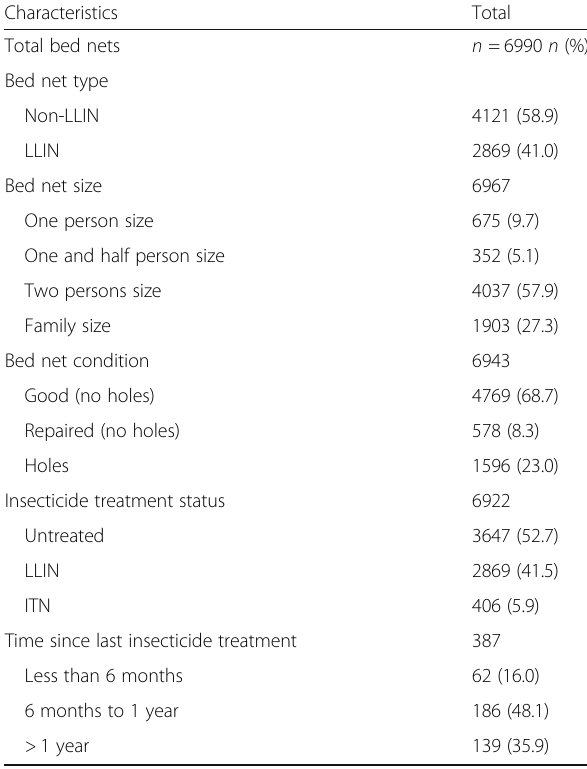
Table 4 Characteristics of bed nets in households among migrant population in RAI project areas of Myanmar, 2014